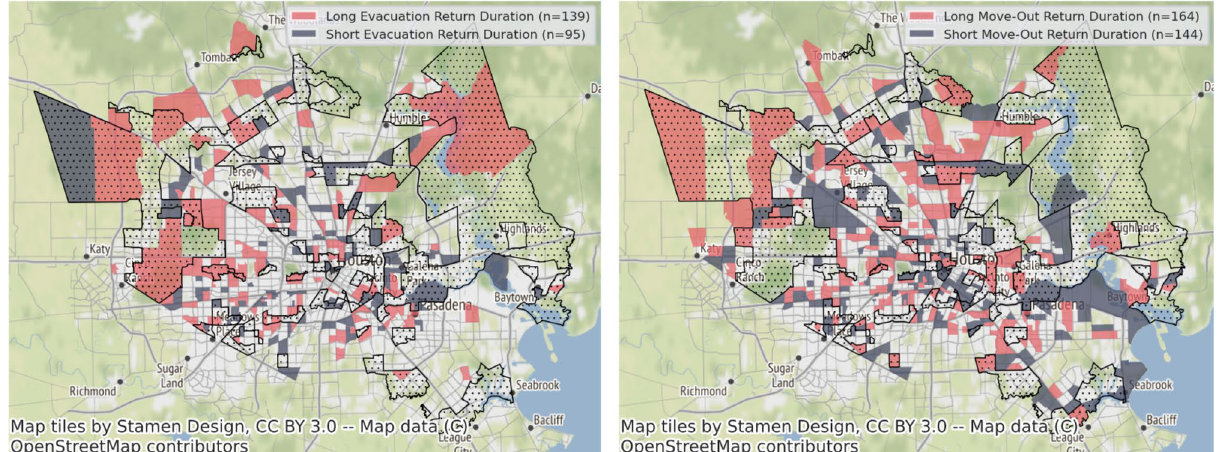
Figure 5. Locations of census tracts with long and short return durations in terms of the evacuation rate (left) and the home move-out rate (right). The criteria for long return duration was greater than 7 days for evacuation rate and 8 weeks for home move-out rate. The criteria for short return duration was less than 5 days for evacuation rate and less than 5 weeks for home move-out rate. The dotted areas are the census tracts identified as flooded census